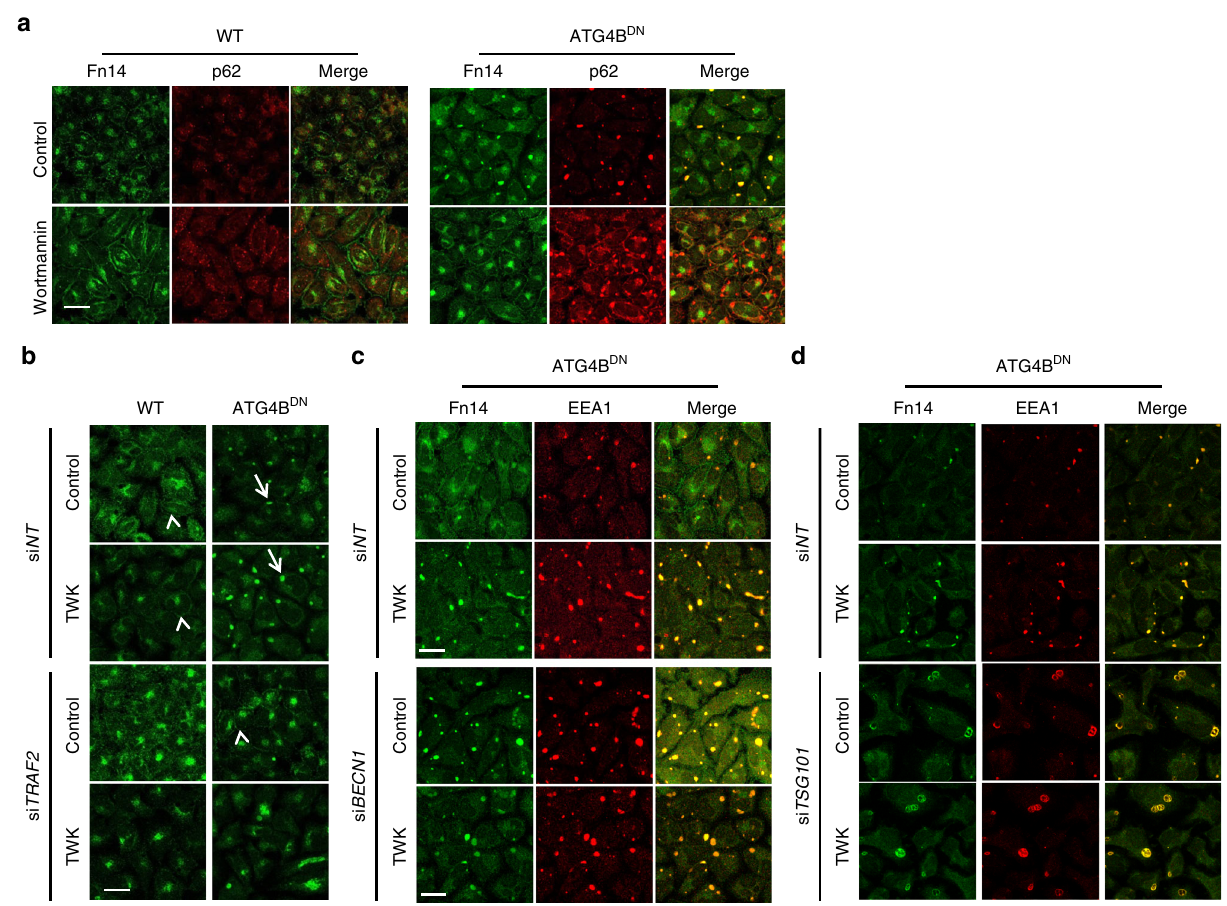
Fig. 5 Autophagy and MVBs both contribute to Fn14 traf fi cking. a – d WT or ATG4B DN stable expression HeLa cells were treated as follows and analyzed by confocal microscopy (scale bar, 20 µ m): a treated with wortmannin as indicated and immunostained for Fn14 and p62; b transfected with si NT or siRNA against TRAF2 (si TRAF2 ), treated with TWK as indicated, and immunostained for Fn14. Arrows and arrowheads point at Fn14 at vesicles and plasma membrane, respectively; c , d transfected with si NT or siRNA against BECN1 (si BECN1 ) ( c ) or TSG101 (si TSG101 ) ( d ), treated with TWK, and immunostained for Fn14 and